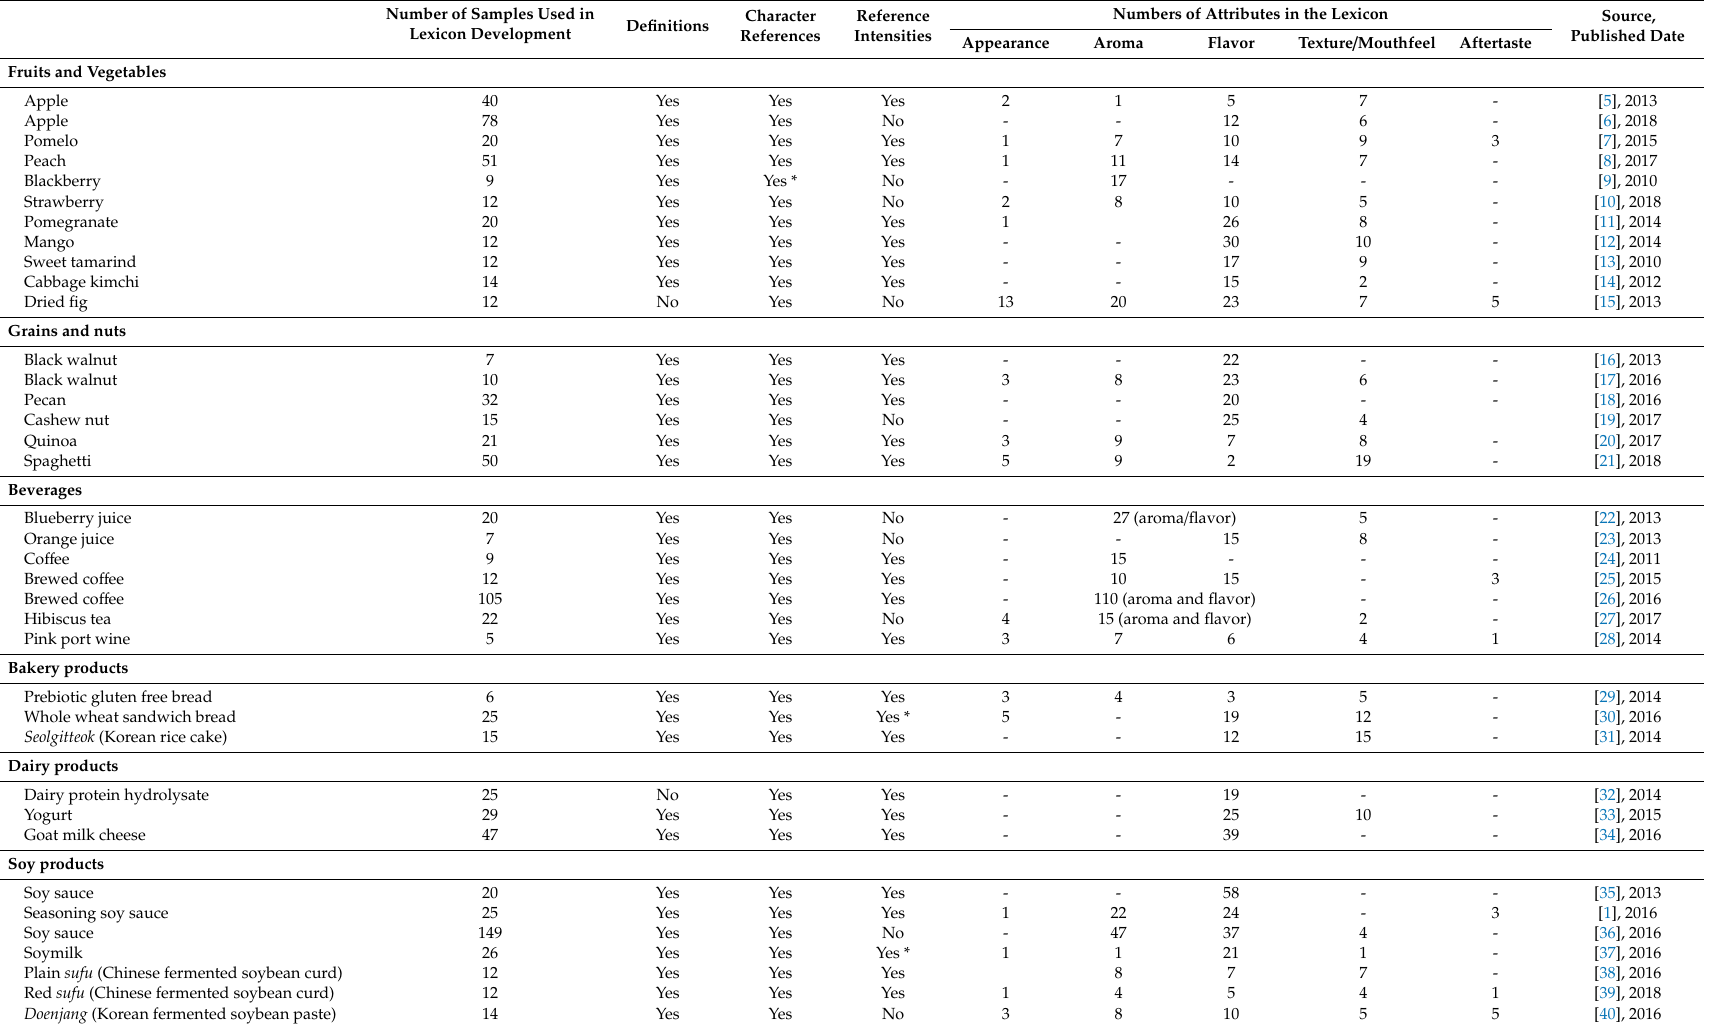
Table 1. Examples of recent food